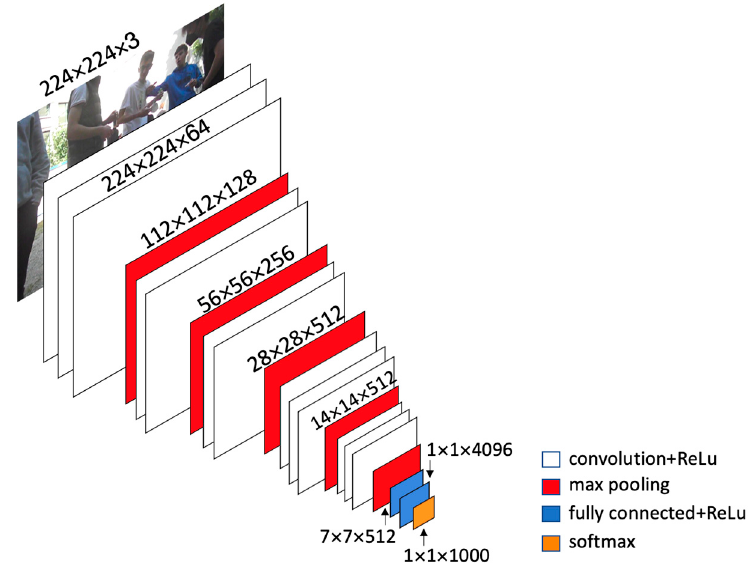
Figure 1. In VGG16 architecture [9], at the initial stage, the image is processed by a stack of convolutional layers of 3 × 3 filters and then a max pool layer of 2 × 2 filters. All hidden layers have been used with rectified Linear Unit (ReLu) being the activation function. The architecture follows the same structure until the end where it has 2 fully connected layers and a softmax for output.